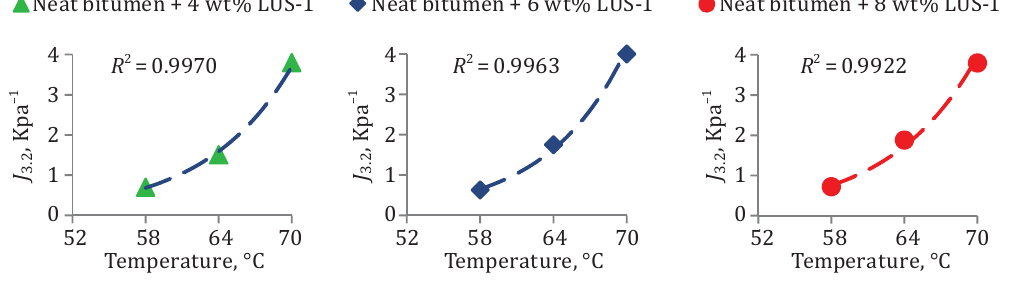
Figure 7. The correlation between temperature and J 3.2